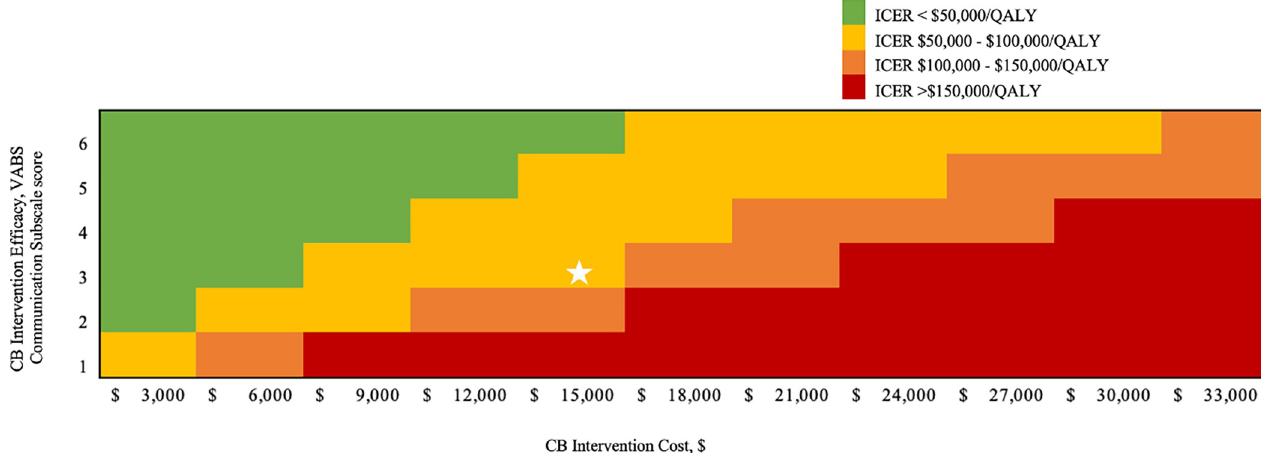
Fig 2. Two-way sensitivity analysis on cord blood intervention efficacy and cost. This figure shows the effect of varying CB intervention efficacy and cost on cost-effectiveness outcomes. CB intervention efficacy on VABS-3 communication subscale score was varied across the Y-axis, from a mean change of 1.0–6.0. CB intervention cost was varied across the X-axis, ranging from $3,000-$33,000. The projected ICER of each combination of efficacy and cost are shown in the Figure and are color coded: green indicates an ICER < $50,000/QALY, yellow an ICER between $50,000–100,000/QALY, orange between $100,000–150,000/ QALY, and red > $150,000/QALY (Legend). The white star indicates the projected cost-effectiveness of DukeACT intervention basecase parameters. CB: cord blood, VABS: Vineland Adaptive Behavior Scale, ICER: incremental cost-effectiveness ratio.